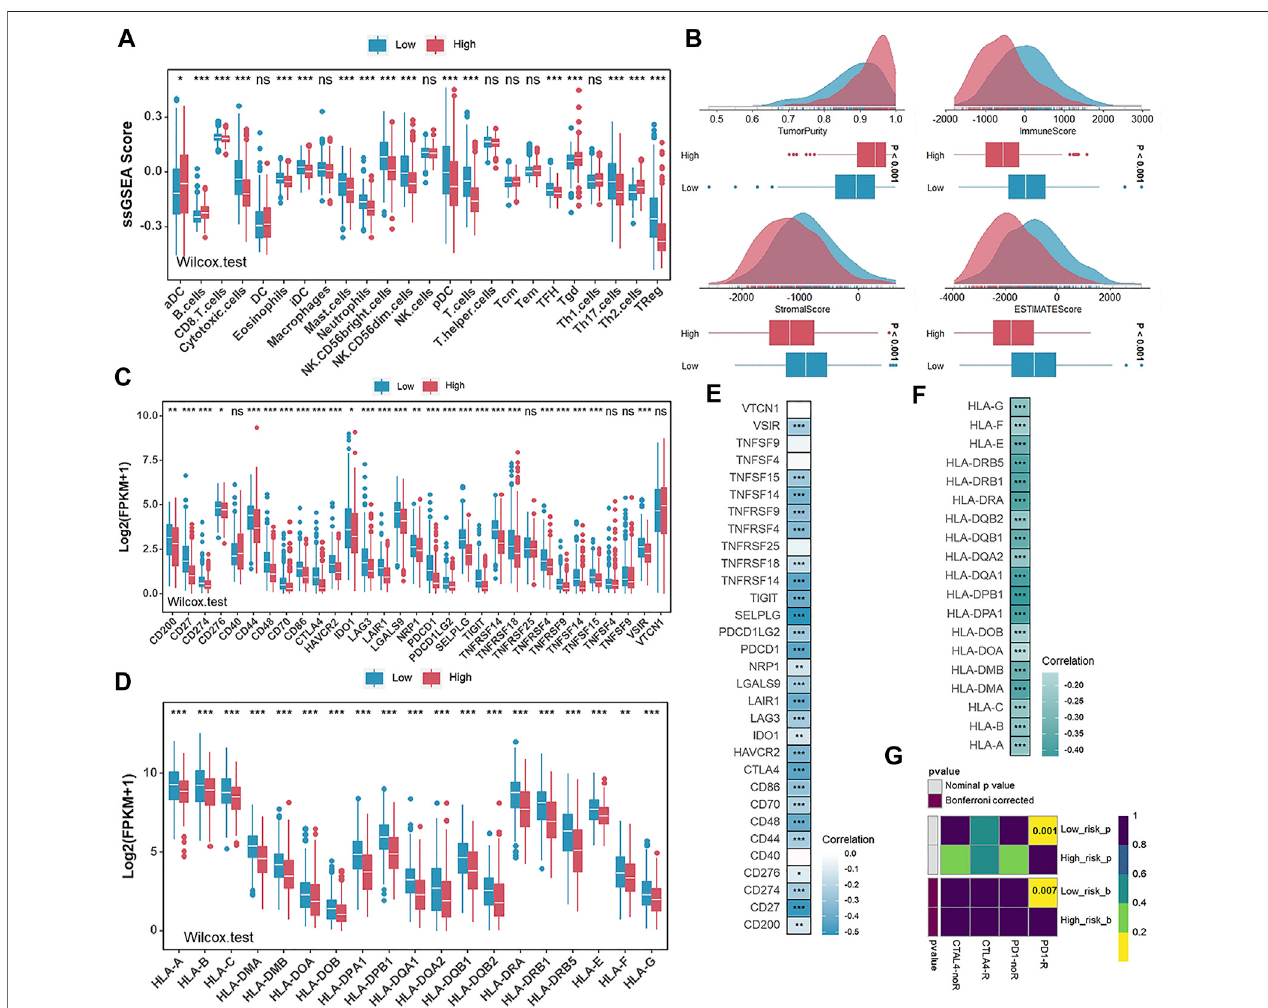
FIGURE 7 | The description of in fi ltration of immune cells and the prediction of immunotherapeutic response in different risk groups. (A) The ssGSEA scores of 24 immune cells in the low- and high-risk groups in TCGA-UCEC. (B) Comparison of ESTIMATE score, immune score, stromal score, and tumor purity between the low- and high-risk groups in TCGA-UCEC. (C,D) The expression levels of immune checkpoint biomarkers (C) and HLA family genes (D) in the low- and high-risk groups in TCGA-UCEC.Eand (F) .Correlationanalysisforriskscoresandtheexpressionlevelsofimmunecheckpointbiomarkers (E) andHLAfamilygenes (F) . (G) Predicted responses to anti-PD1 therapy and anti-CTLA4 therapy of patients with UCEC in the low- and high-risk groups.